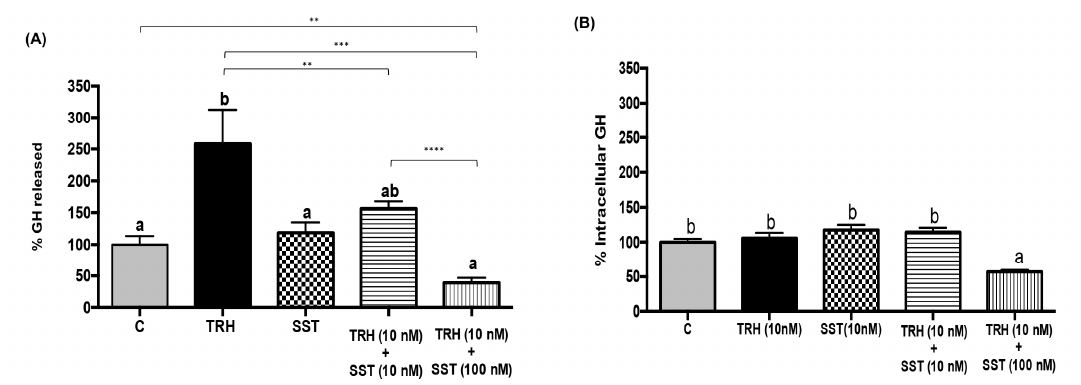
Figure 6. Inhibitory effect of SST upon TRH-induced GH release in BBLs. GH was determined by ELISA in either culture media ( A ) or intracellular content ( B ) in response to incubation with 10 nM TRH, 10 nM SST, or the combination of TRH (10 nM) with SST (10 or 100 nM), after one-hour treatment. Each bar represents mean ± SEM. The data were obtained from three independent experiments and expressed as percentage (%). Group with different letters are significantly different as compared with control conditions. We used one-way ANOVA with multiple comparison test and Tukey as post-hoc test, ( p < 0.001). Asterisks indicate differences between experimental groups as determined by unpaired t test. ** p < 0.01; *** p < 0.001; **** p < 0.0001.